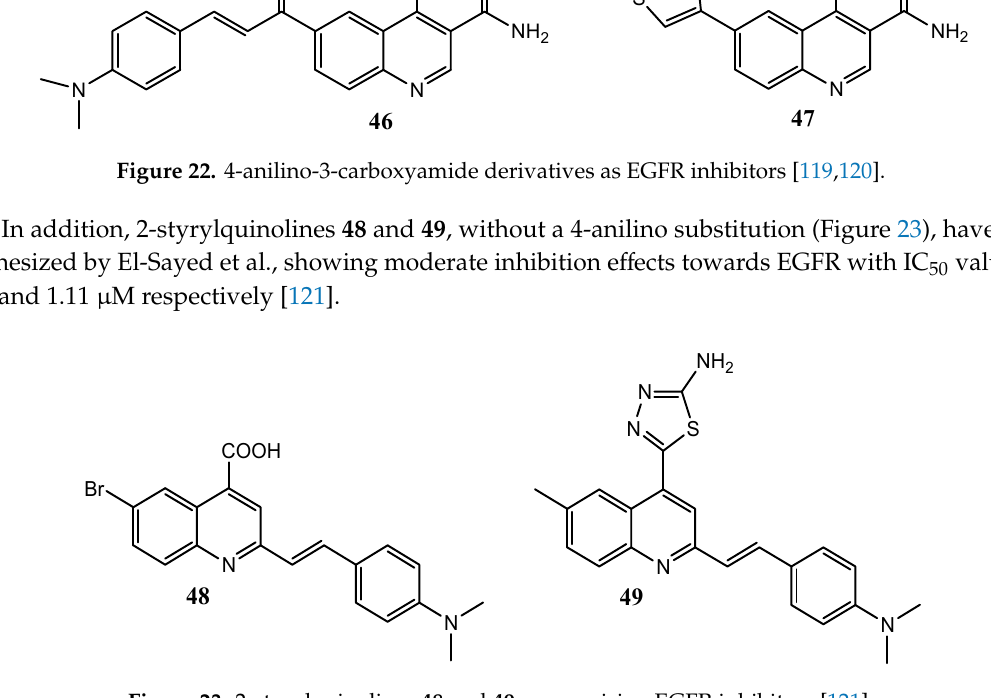
Figure 23. 2-styrylquinolines 48 and 49 as promising EGFR inhibitors [121].